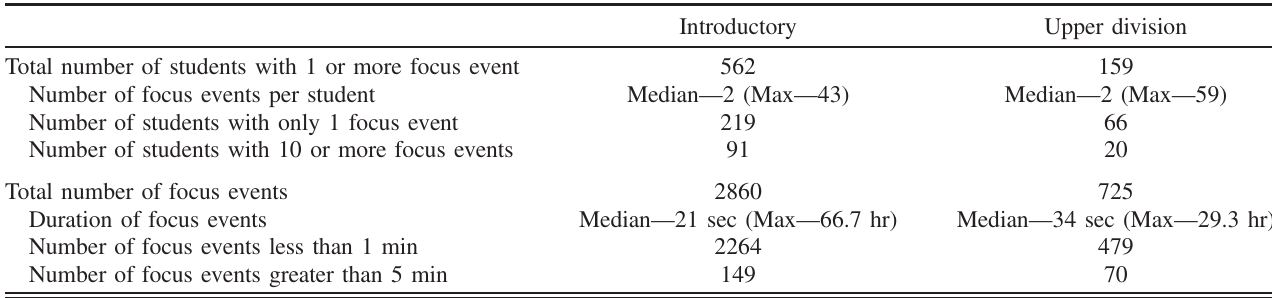
TABLE II. Duration and number of sustained browser hidden events in the introductory and upper-division student population.